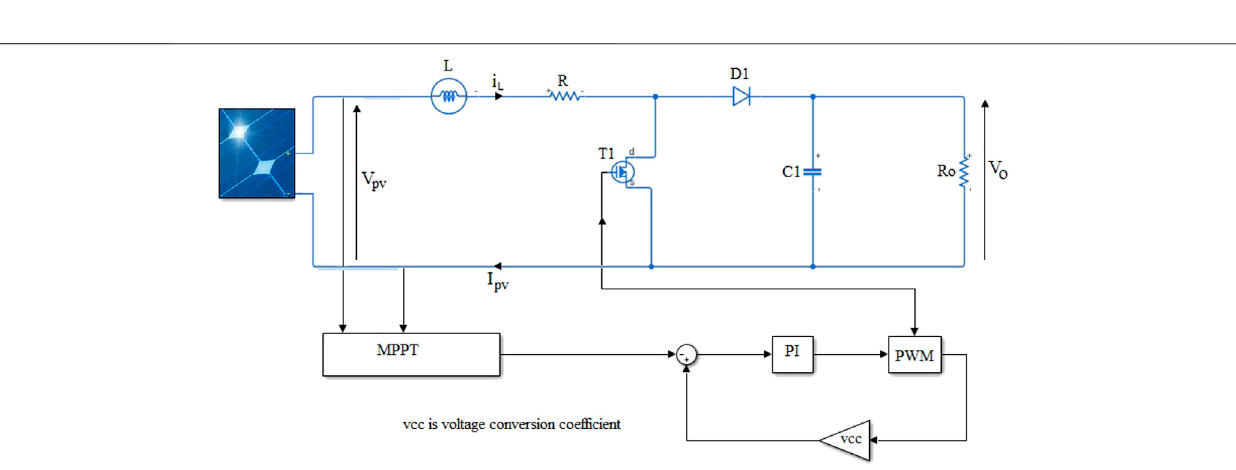
Frontiers in Energy Research |